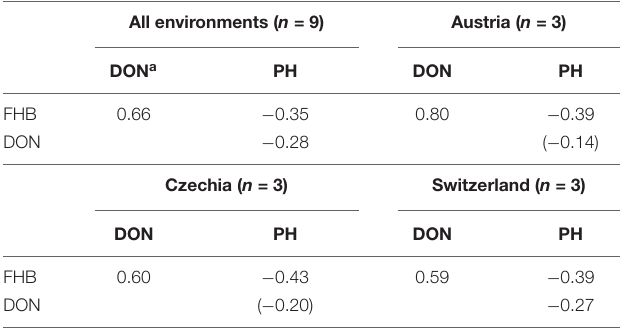
TABLE 3 | Trait correlations based on best linear unbiased estimators (BLUEs) derived from overall analysis and country-specific analysis. All environments ( n =